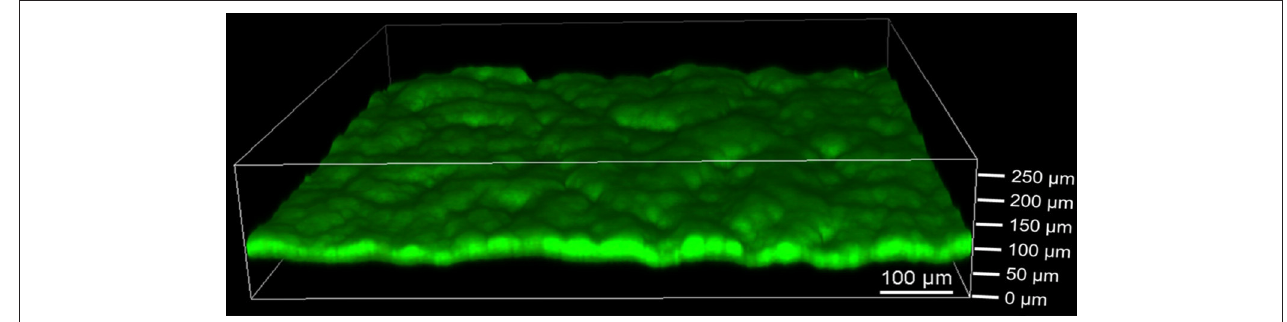
FIGURE 5 | Confocal laser scanning microscope image of defined mixed culture of G. sulfurreducens and S. oneidensis on graphite anode stained with acridine orange (green) and propidium iodide (red) for live/dead staining. Five images were taken per experiment and experiments were performed in biological triplicates.